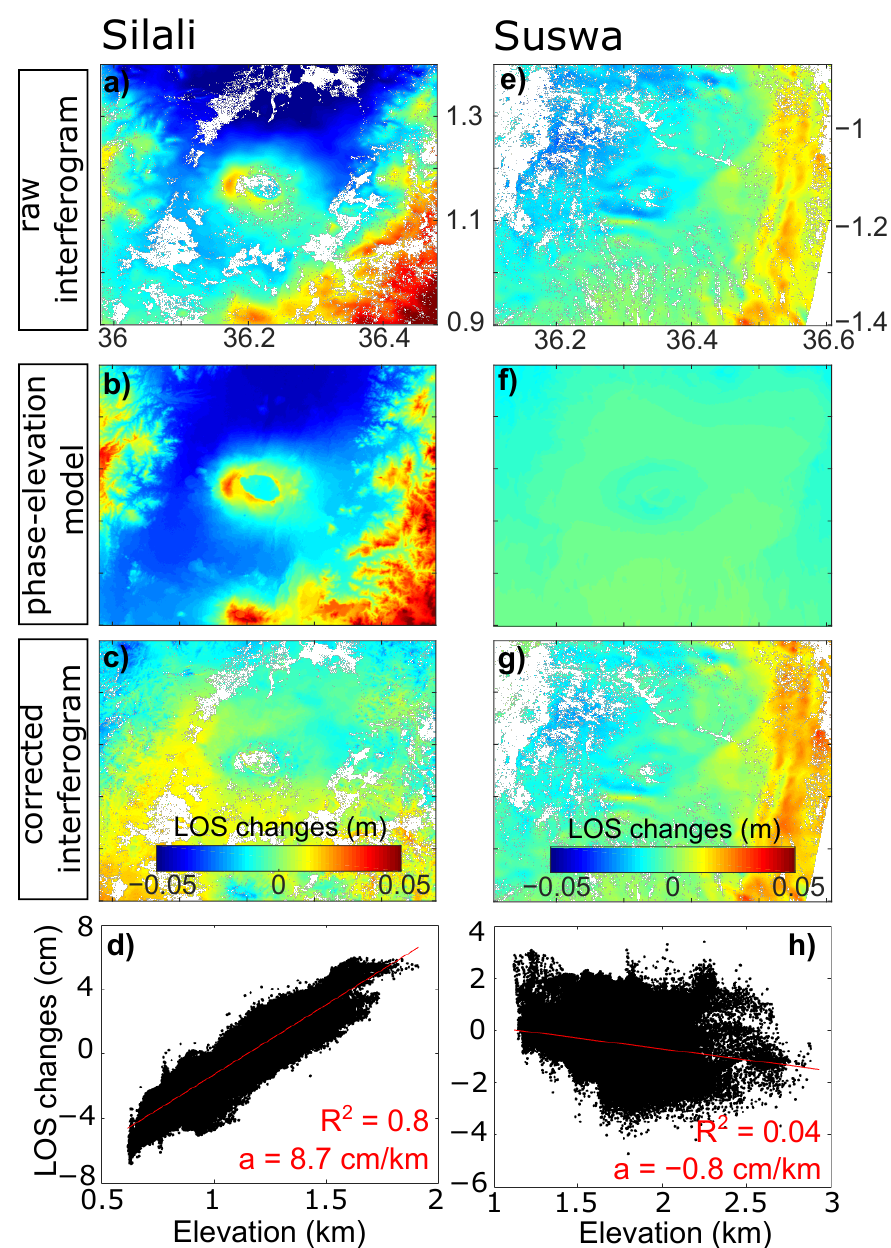
Figure 3. Atmospheric corrections using the empirical method of linear phase-elevation correlation. The top row shows an example for Silali volcano showing high correlation ( R 2 = 0.8) with ( a ) the interferogram, ( b ) the phase-elevation model, ( c ) the corrected interferogram and ( d ) the phase- elevation plot. The bottom row shows an example for Suswa volcano showing low correlation ( R 2 = 0.04) with ( e ) the interferogram, ( f ) the phase-elevation model, ( g ) the corrected interferograms and ( h ) the phase-elevation